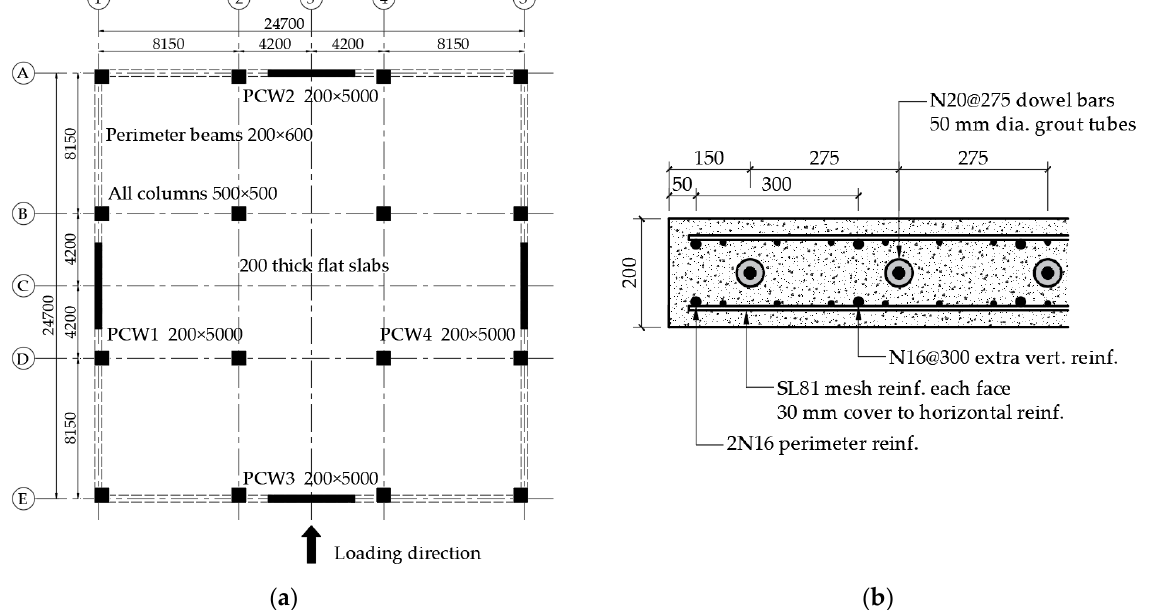
Figure 13. Case study building supported by rectangular lightly reinforced precast walls. ( a ) Typical floor plan of the case study building. ( b ) Cross-section of precast walls at the base.